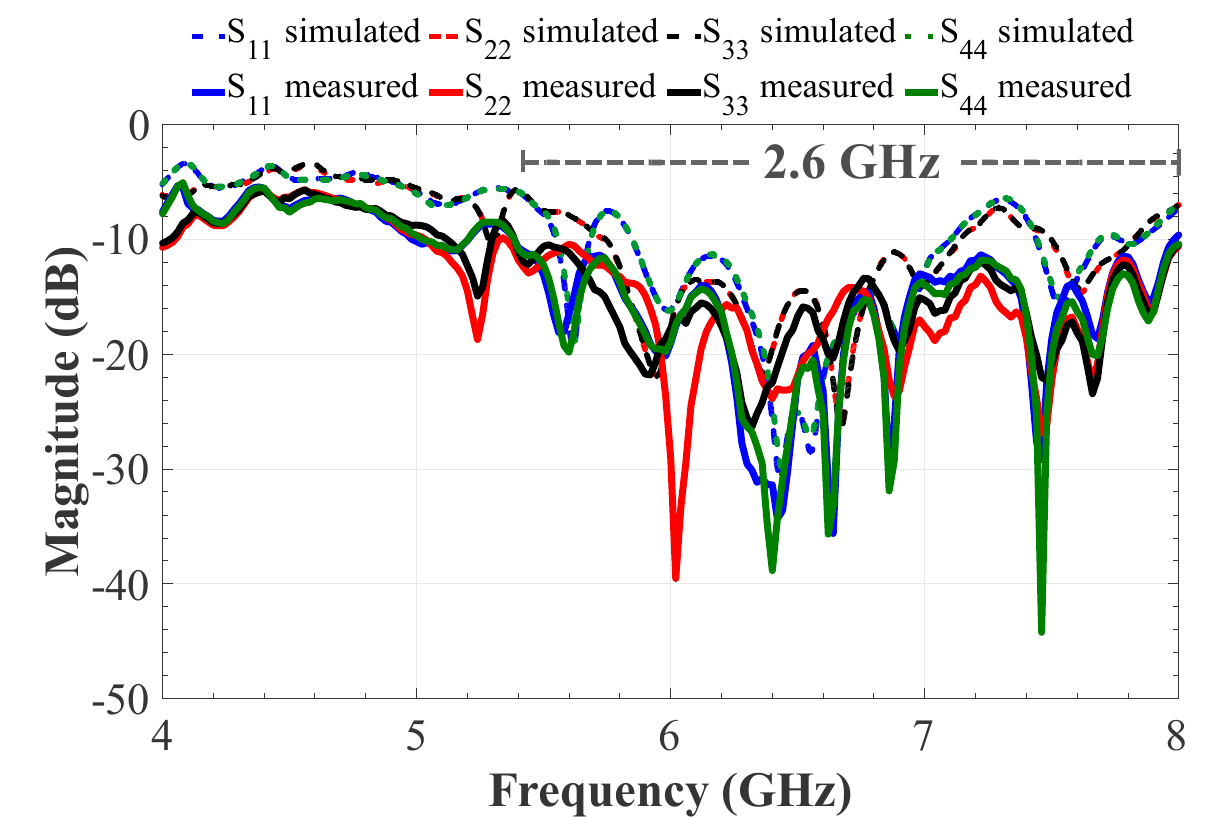
Figure 6. Fabricated prototype of the proposed feeding system.